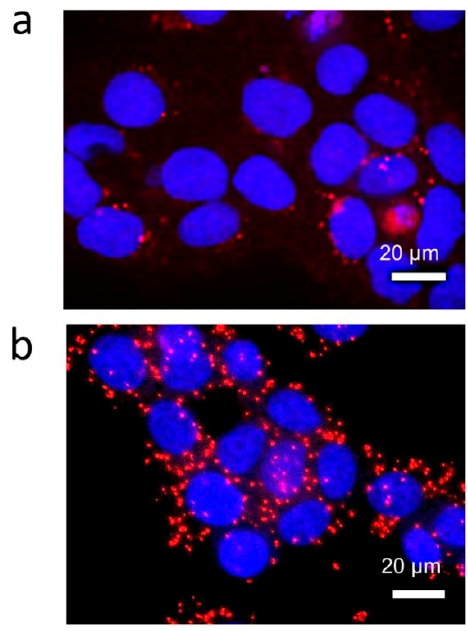
Figure 2. Imaging of mRNAs by rolling circle amplification (RCA) in the circular-shaped microchamber. ( a ) Detection of KRAS codon 12 (wild type) mRNA in the choriocarcinoma cell line BeWo. ( b ) Detection of β -actin mRNA in the colorectal carcinoma cell line HCT116.